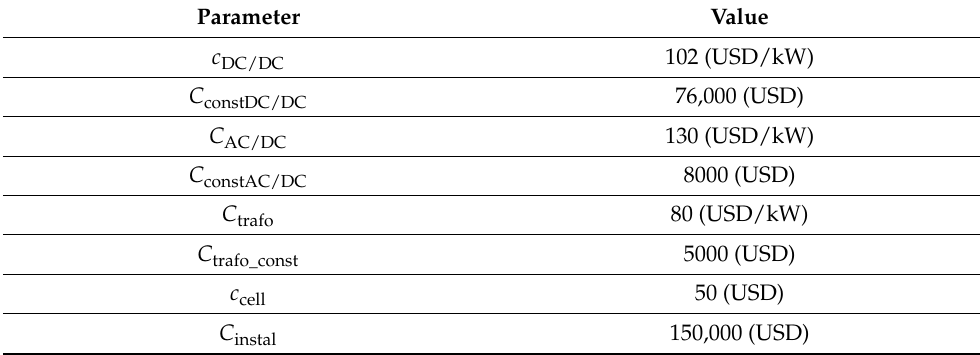
Table 5. The parameters used for supplying points cost calculation.